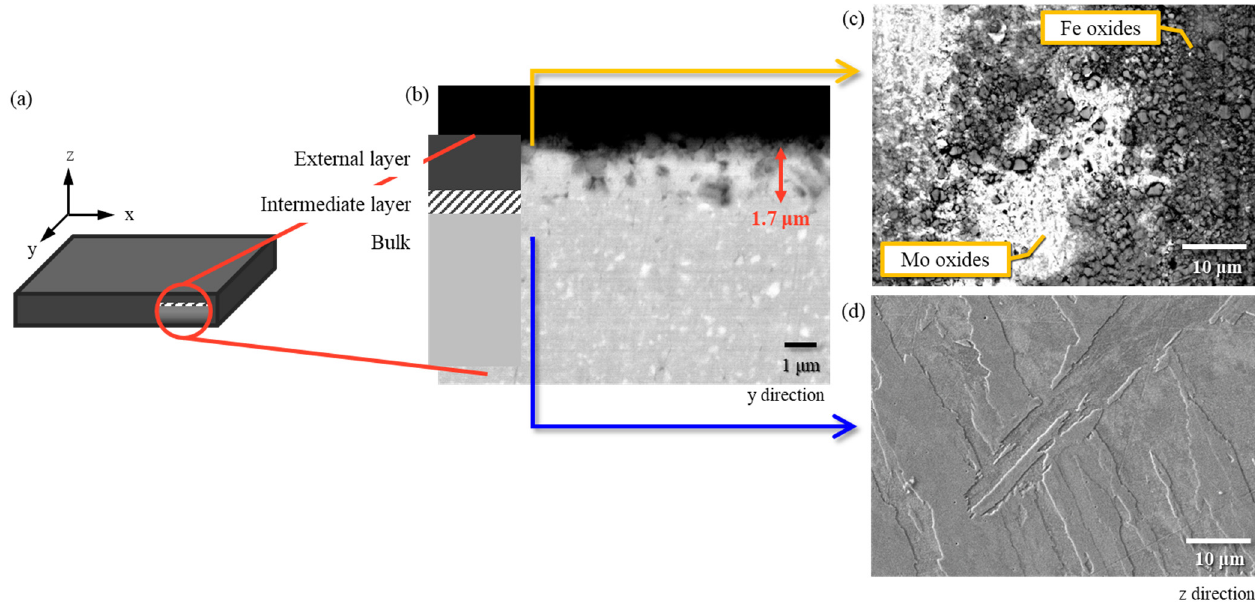
Figure 1. Schematic illustration of the studied regions: External layer, Intermediate layer and Bulk. ( a ) Sheet illustration and directions orientation; ( b ) SEM(BSE) image of the cross section (y direction), annealed sample as polished; ( c ) SEM(BSE) image of the external layer (z direction), light gray region is rich in molybdenum and dark gray region is rich in iron, annealed sample without any preparation ( d ) SEM(SE) image of the bulk (z direction) showing the martensite microstructure, annealed sample polished and etched.